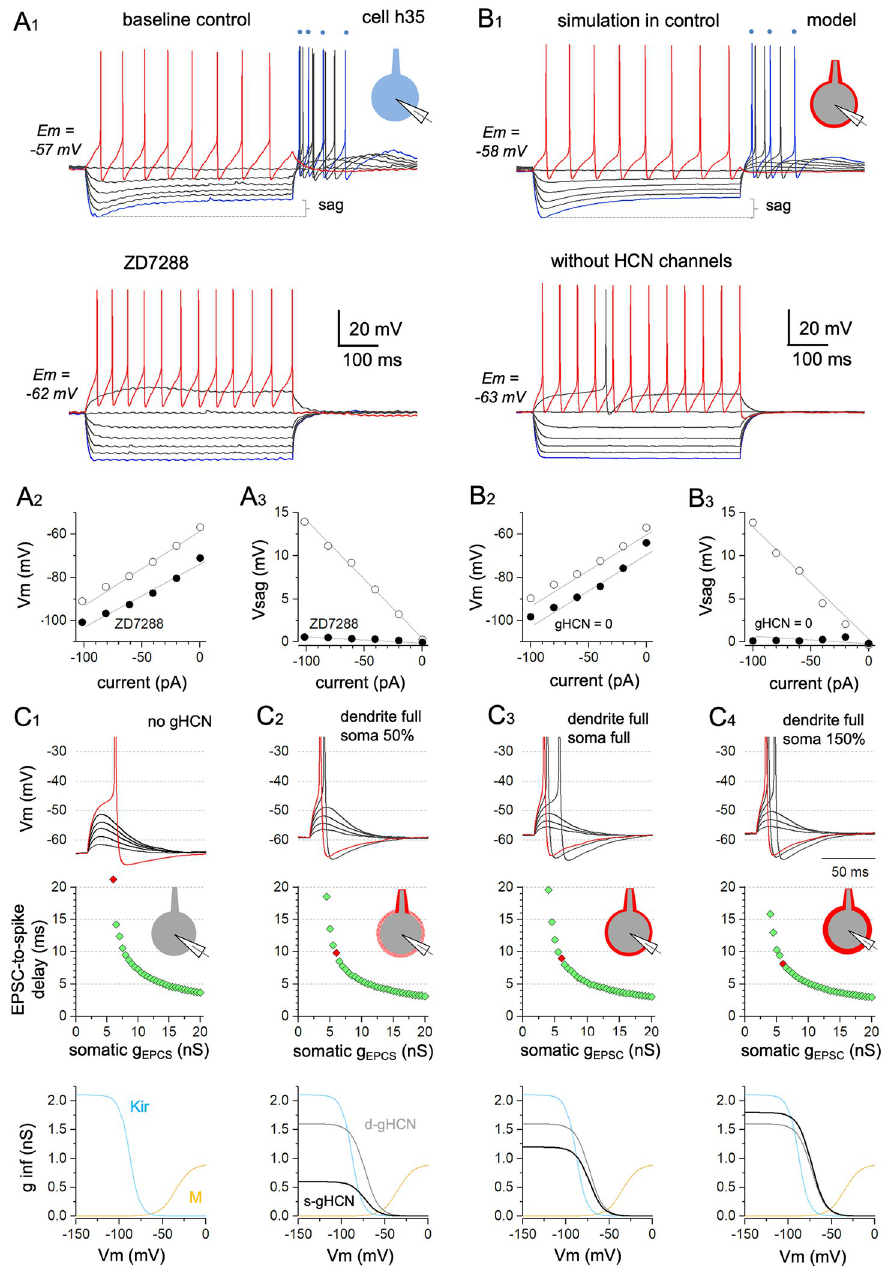
Fig 6. A computational model demonstrates the effects of perisomatic HCN conductance modulation on human basket cell excitability and input–output function. A three-compartmental model neuron with standard Hodgkin– Huxley-type spike-generating Na + and K + currents, slowly activating M-type K + current (M), inward-rectifying K + current (Kir), HCN current, and a physiological GABAergic autaptic conductance at the somatic compartment [35] reproduces the physiological behavior and EPSP–spike coupling of a human fast-spiking pv interneuron. ( A ) Membrane potential features recorded in human fast-spiking cell h35. ( A1 ) Membrane potential responses to 500-ms current steps starting at − 100 pA (blue trace) and reaching +20 pA (red traces) applied at Em ( − 57 mV). The bottom voltage traces are in the presence of the HCN channel blocker ZD7288 at Em = − 62 mV. ZD7288 abolishes sag amplitude (sag) and rebound firing (blue dots show timing of rebound spikes for one membrane potential step). (Inset schematic indicates whole-cell recording from biological cell). ( A2 ) Plot showing the peak negative voltage (Vm) against injected hyperpolarizing current-step amplitude at baseline (open symbols) and following ZD7288 wash-in (solid symbols). ( A3 ) Voltage sag amplitude (Vsag) generated by incrementally increasing hyperpolarizing current steps (amplitude shown on abscissa) at baseline (open symbols). Black symbols illustrate blockade of sag by ZD7288.